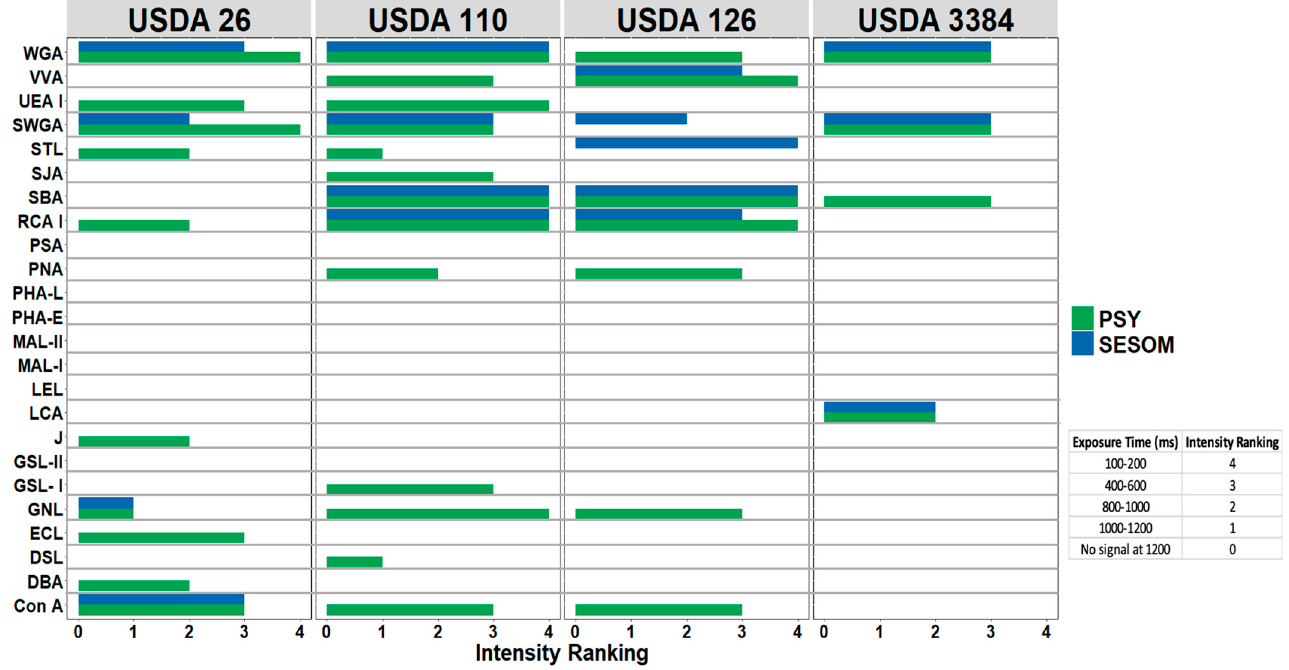
Figure 3. Lectin binding profiles of Bradyrhizobium strains cultured in either PSY-Arabinose or SESOM to mid-exponential phase. Binding intensity was scored by the shortest exposure time yielding visible fluorescence, with 100 ms scoring level 4, and <1200 ms scoring level 0.